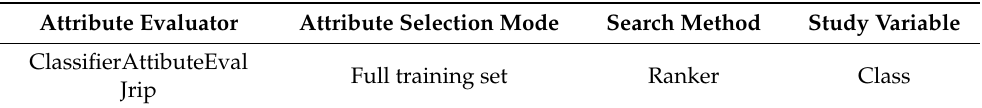
Table 5. Configuration of the second attribute evaluator.